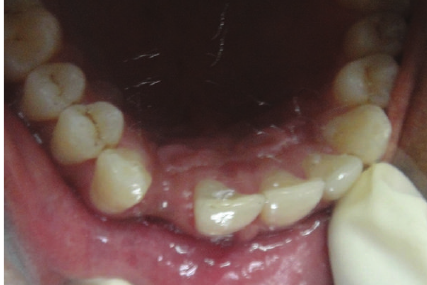
Figure 2: Preoperative occlusal view of the edentulous area.